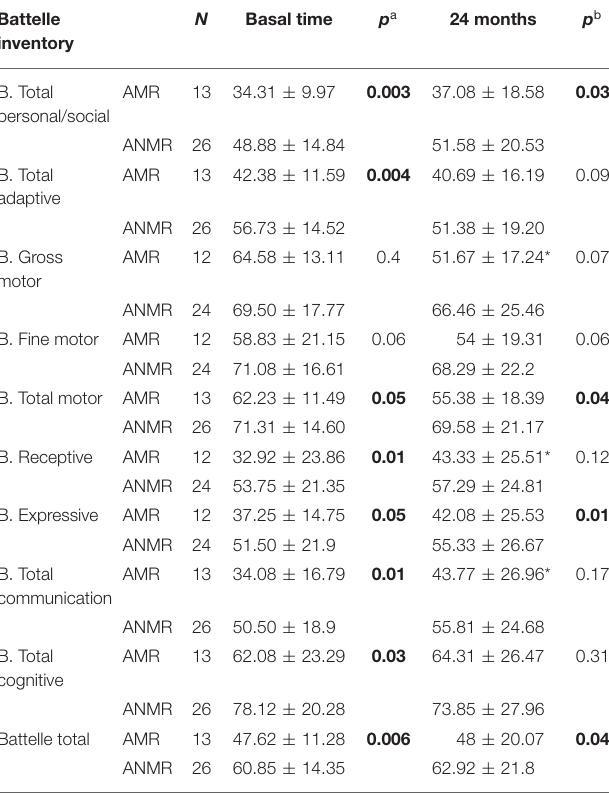
TABLE 3 | Comparisons of the Battelle Inventory results in the autism spectrum disorder subgroups with and without neurodevelopmental regression at baseline and at a follow-up of 24 months.